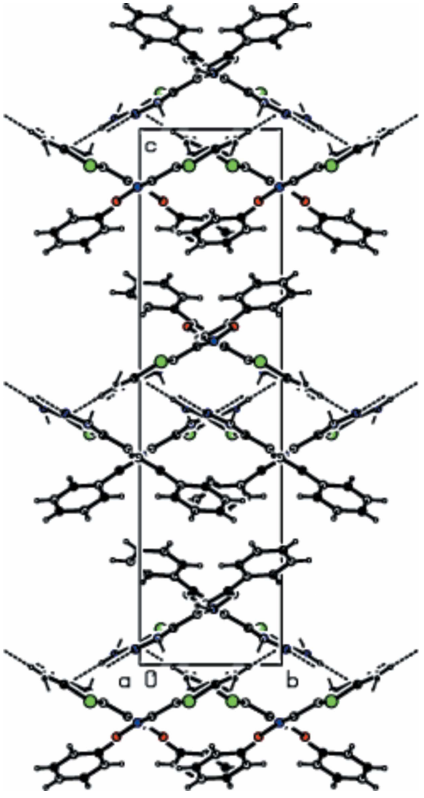
Figure 2 Overlay image of two independent molecules in the asymmetric unit of the title compound.